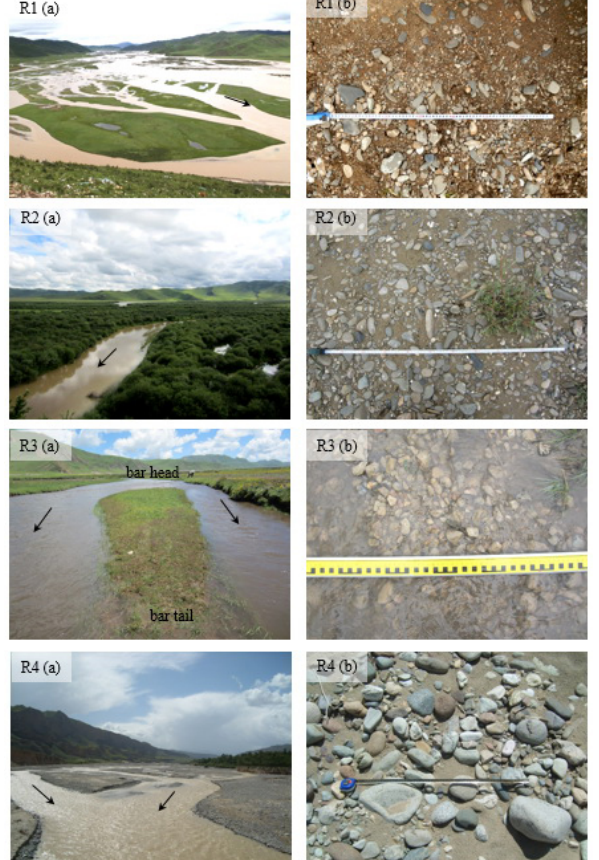
Figure 2. R1: channel morphology and gravel bed of the Dari reach (photographs taken on 2 July 2012, 33.7553 ◦ N, 99.6414 ◦ E; 3960m elevation), R2: channel morphology and gravel bed of the Maqu reach (photographs taken on 8 July 2012, 33.3594 ◦ N, 102.0553 ◦ E; 3465m elevation), R3: channel morphology and gravel bed of a grass covered bar in the middle Lanmucuo River (photographs taken on 5 July 2012, 34.4287 ◦ N, 101.4663 ◦ E; 3604m elevation), R4: channel morphology and gravel bed of the middle Daheba River (photographs taken on 6 August 2011, 35.5169 ◦ N, 100.0183 ◦ E; 2832m elevation).